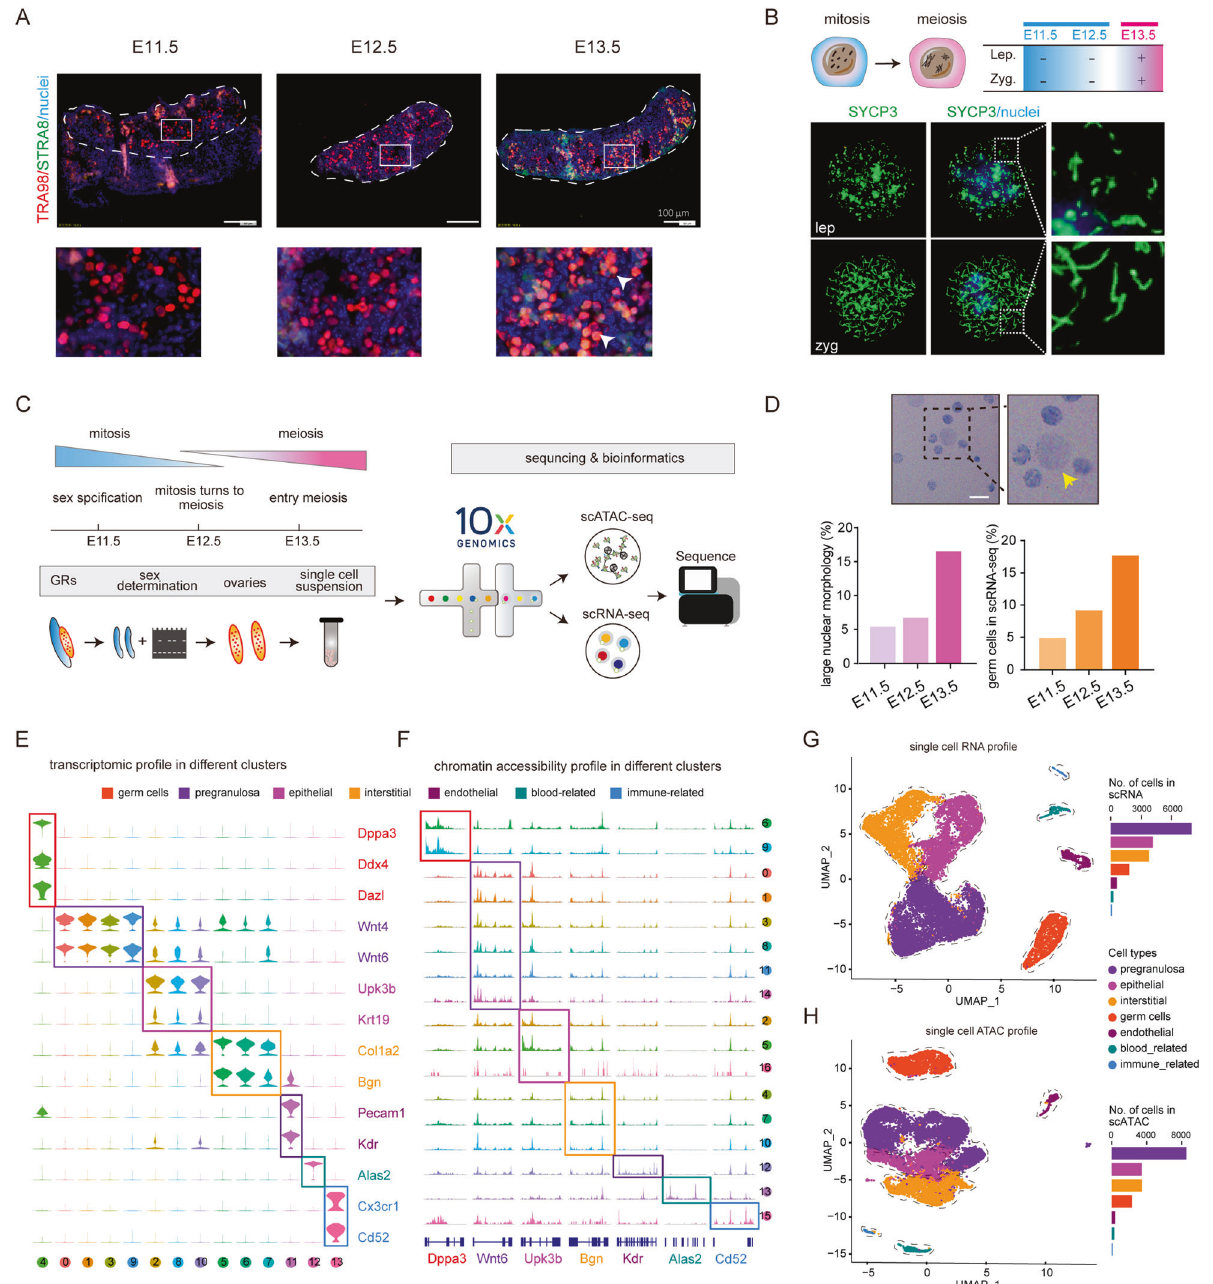
Fig. 1 Single-cell atlas of E11.5 – 13.5 mouse ovaries. A E11.5 – 13.5 female mouse genital ridge sections were stained as indicated. Enlarged images are shown on the bottom; Red shows TRA98, green shows STRA8, and blue shows nuclei; bar = 100 μ m. B Identi fi cation of the time of meiotic initiation according to chromosome cytospreads; Green shows SYCP3 and blue shows nuclei; bar = 1 μ m. C Work fl ow employed to investigate the molecular mechanism of meiotic initiation by single-cell multiomics. GRs gonadal ridges. D Example of normal and large nuclei (up). Percent of germ cells with a large nucleus and of germ cells identi fi ed in the gonadal cell populations using scRNA-seq; bar = 10 μ m. E Violin plot of marker gene expression across seven ovarian cell types, including germ cells, epithelial cells, endothelial cells, pregranulosa cells, interstitial cells, immune-related cells, and blood-related cells. F Chromatin accessibility of key marker genes in the different clusters. G , H Single-cell RNA pro fi le ( G ) and single-cell ATAC pro fi le ( H ) of ovarian cells of E11.5 – 13.5 female mouse genital ridge; The barplot on the right shows the number of cells in different cell